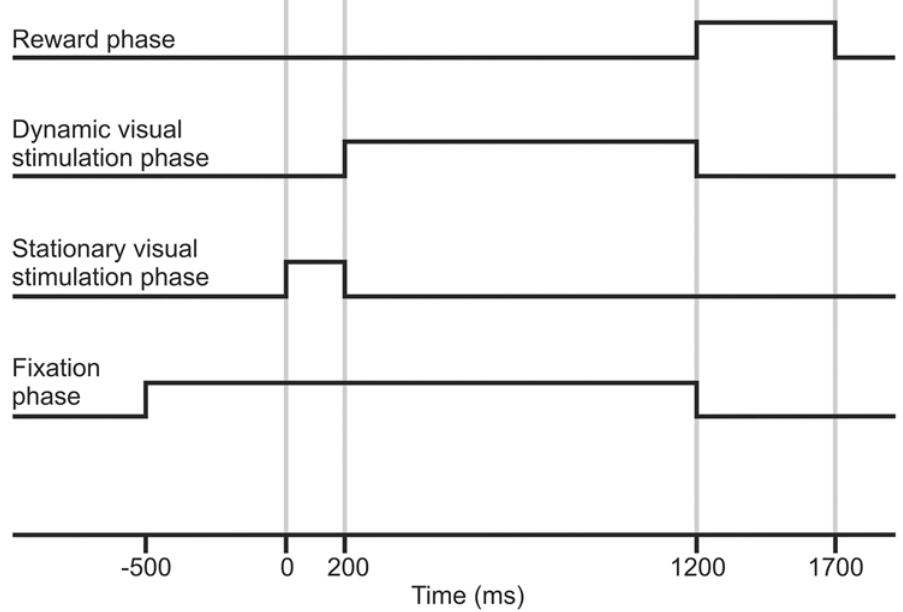
Fig 1. Schematic representation of the phases of the behavioral paradigm. At the beginning of the trial the cat has to direct its gaze to a green fixation point projected in the center of a CRT monitor (refresh rate 100 Hz). Then, the animal has to maintain fixation within an acceptance window for 500 ms (fixation phase). If the fixation phase is successfully accomplished, a static random dot pattern appears (at 0 ms), and it remains on the screen for 200 – 500 ms (static stimulation phase). After this, the dots of same static pattern start to move coherently in a radial center-in or center-out direction (optic flow, dynamic stimulation phase, 1000 ms). As can be seen in the figure, the animal has to hold fixation throughout the stimulation phases. If it manages to do so, the trial is accepted, and the animal is rewarded with a few drops of mashed cat food (reward phase, 500